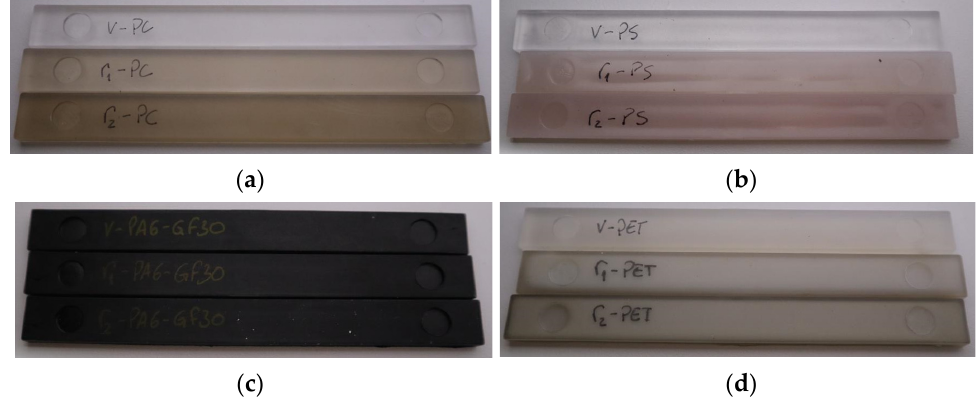
Figure 1. Examples of the injection-moulded specimens: ( a ) PC; ( b ) PS; ( c ) PA6-GF30; ( d ) PET.